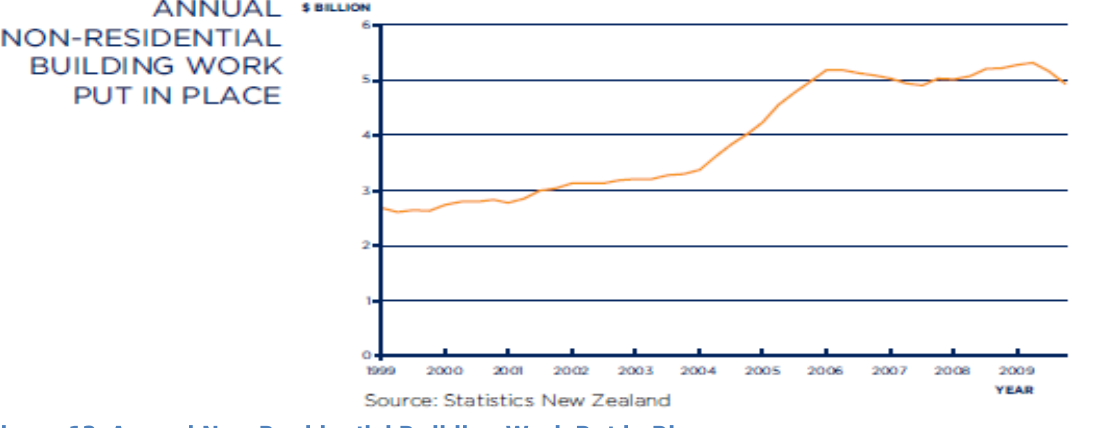
Figure 13 Annual Non-Residential Building Work Put in